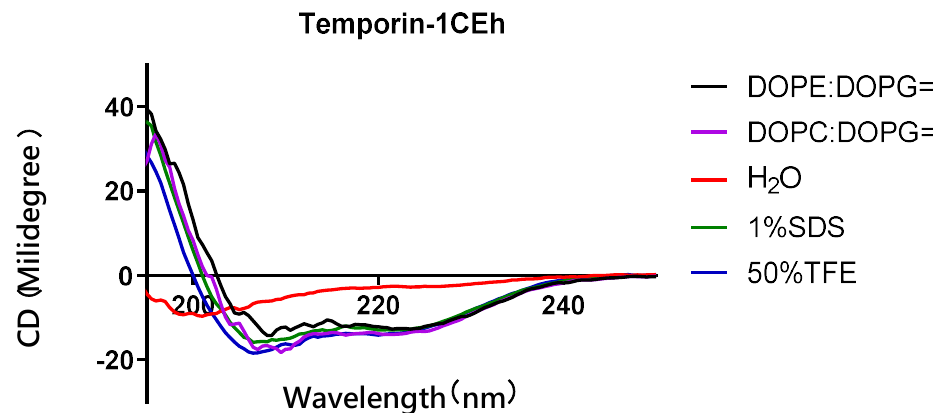
Figure 6. Circular dichroism (CD) spectra of 50 µM of Temporin-1CEh in H2O, 50% TFE solution, 1% SDS solution of S. aureus (DOPC:DOPG = 1:1) and E. coli (DOPE:DOPG = 3:1)-membrane-mimicking environments.